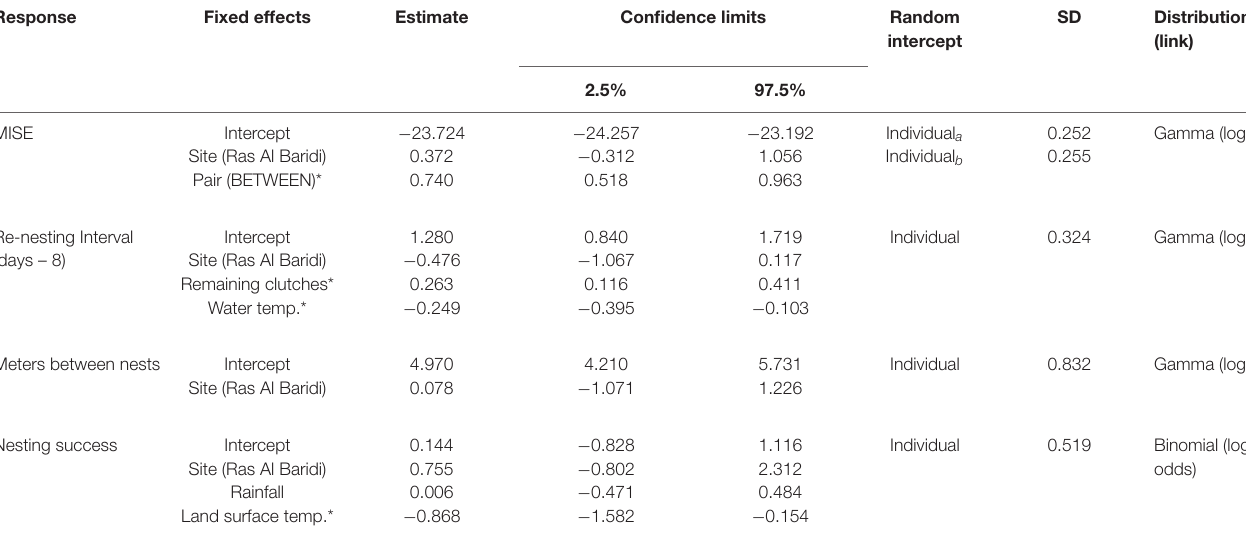
TABLE 1 | Summary of GLMMs fitted to mean integrated squared errors ( MISE ) as a measure of individual’s fidelity to inter-nesting habitat, re-nesting interval as the number of days between a nesting event and the successive emergence onto the beach, meters between nests as a measure of individual’s fidelity to nest site, and nesting success as the probability of nesting by a female per an emergence onto the